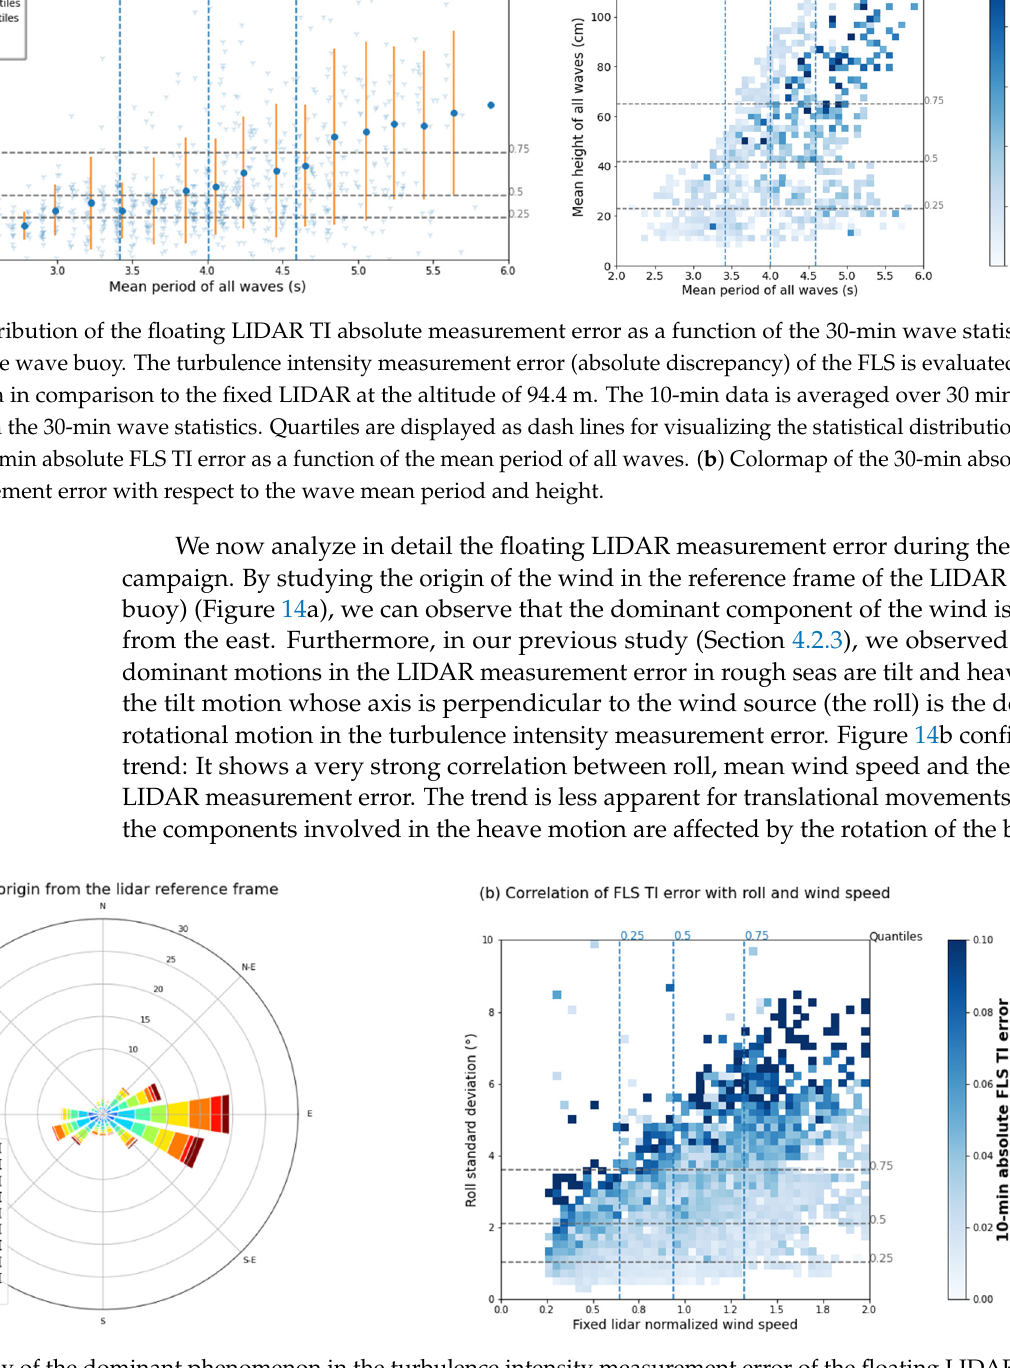
Figure 14. Study of the dominant phenomenon in the turbulence intensity measurement error of the floating LIDAR on the Fécamp site. ( a ) Origin of the winds in the floating LIDAR reference frame, the color scale designates the normalized horizontal speed. ( b ) Colormap of the absolute TI measurement error of the floating LIDAR with respect to the fixed LIDAR as a function of roll standard deviation (in degrees) and normalized mean wind speed.